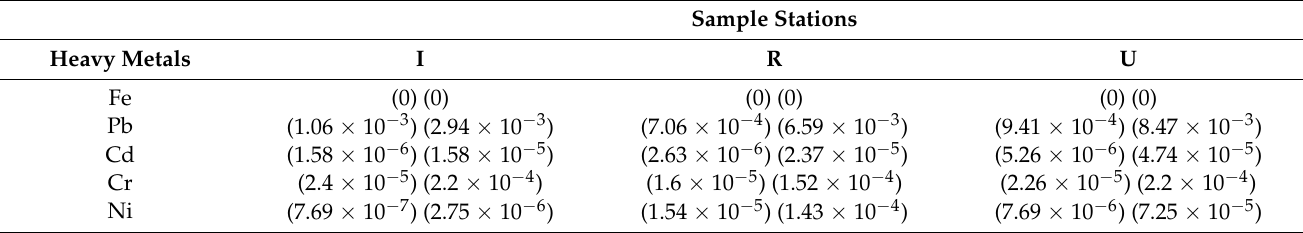
Table 8. Incremental Lifetime Cancer Risk ( ILCR ) in soil for children and adults.